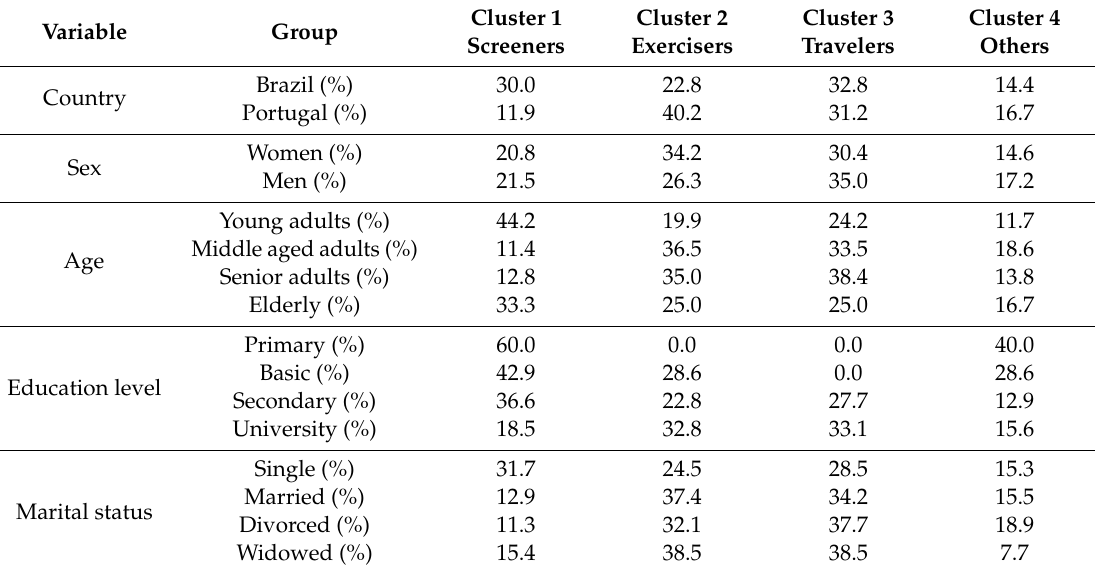
Table 10. Cluster membership according to sociodemographic variables.